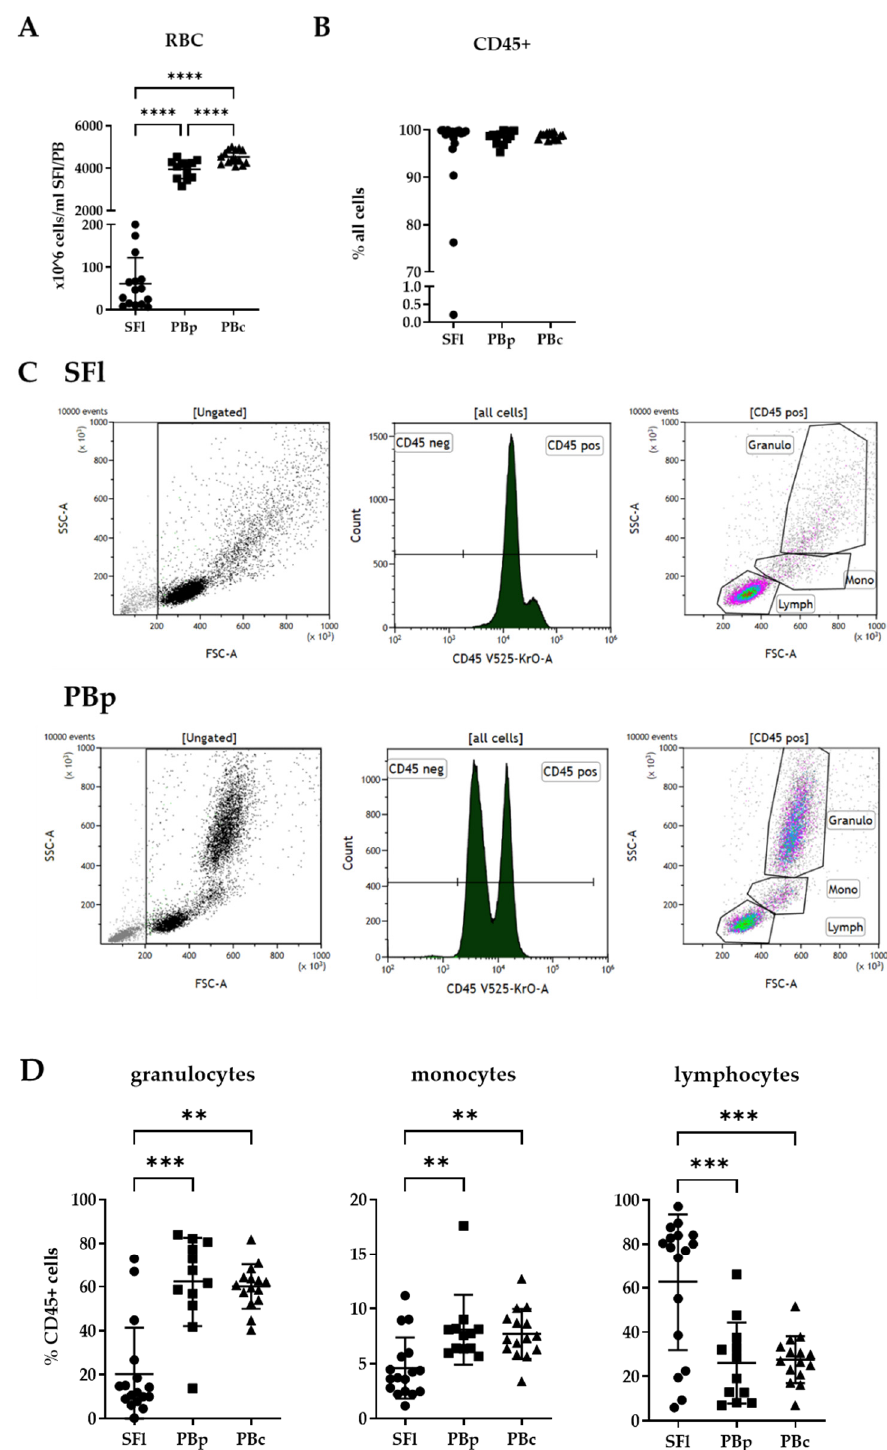
Figure 1. Cell composition of seroma fluid (SFl) and peripheral blood of patients (PBp) and controls (PBc) by flow cytometry analysis or automated cell counting. ( A ) Total cell count of RBCs in SFl and PBp/c determined by automated cell counting (Sysmex). ( B ) Percentage of CD45+ leucocytes in relation to all cells recorded. ( C ) Gating strategy of granulocytes (Granulo), monocytes (Mono), and lymphocytes (Lymph) in SFl and PBp after staining with panel 1; debris was excluded by size discrimination. ( D ) Percentages of granulocytes, monocytes, and lymphocytes within the CD45+ cell population; ** p < 0.01, *** p < 0.001, **** p < 0.0001.